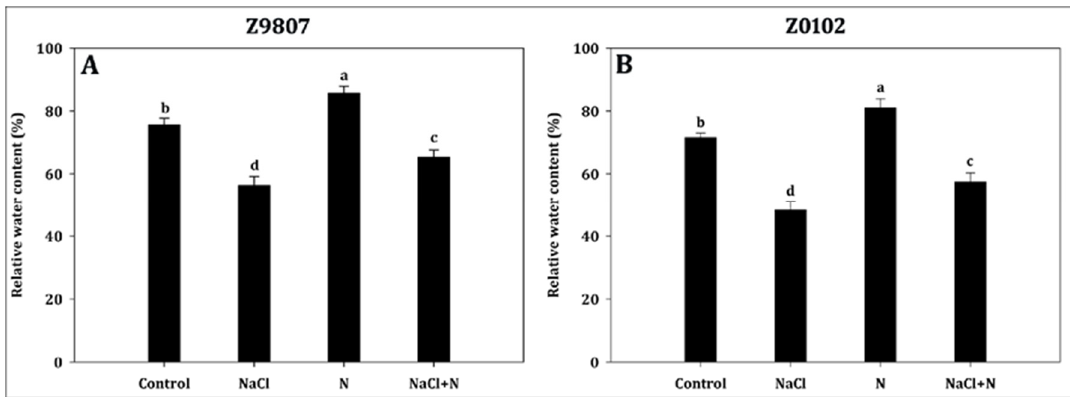
Figure 6. Effect of nitrogen supplementation on leaf relative water content in Gossypium hirsutum L. under salinity stress. Data represent the mean of three replicates and bars with different letters denote significant differences at p < 0.05.